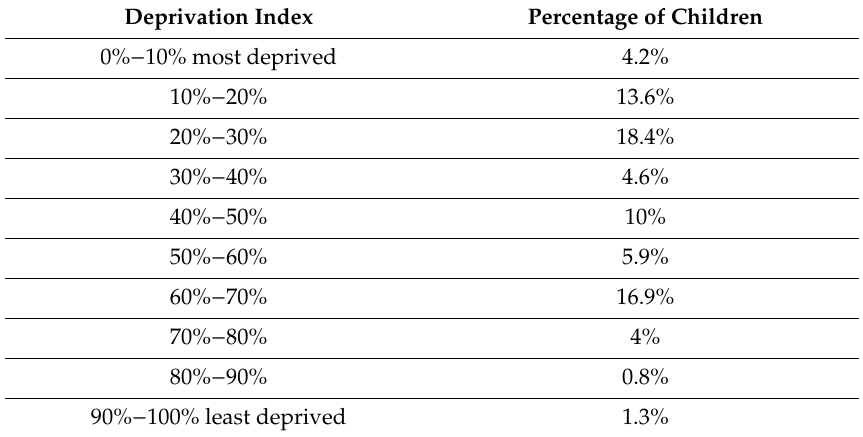
Table 1. Background of children of the primary school based on the deprivation index (Source: Primary School).